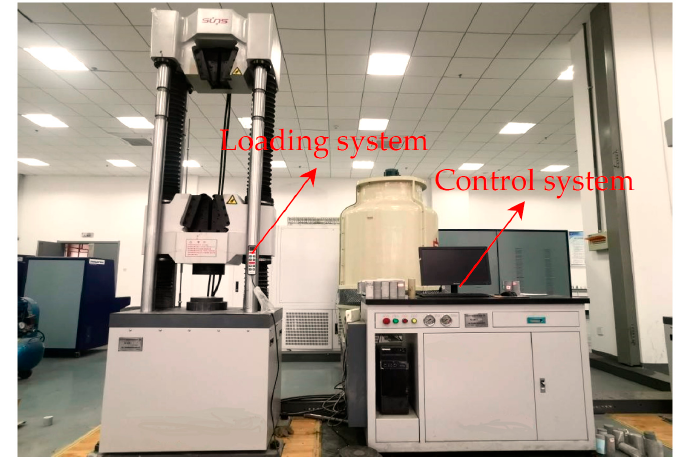
Figure 2. WAW-1000 universal testing machine.